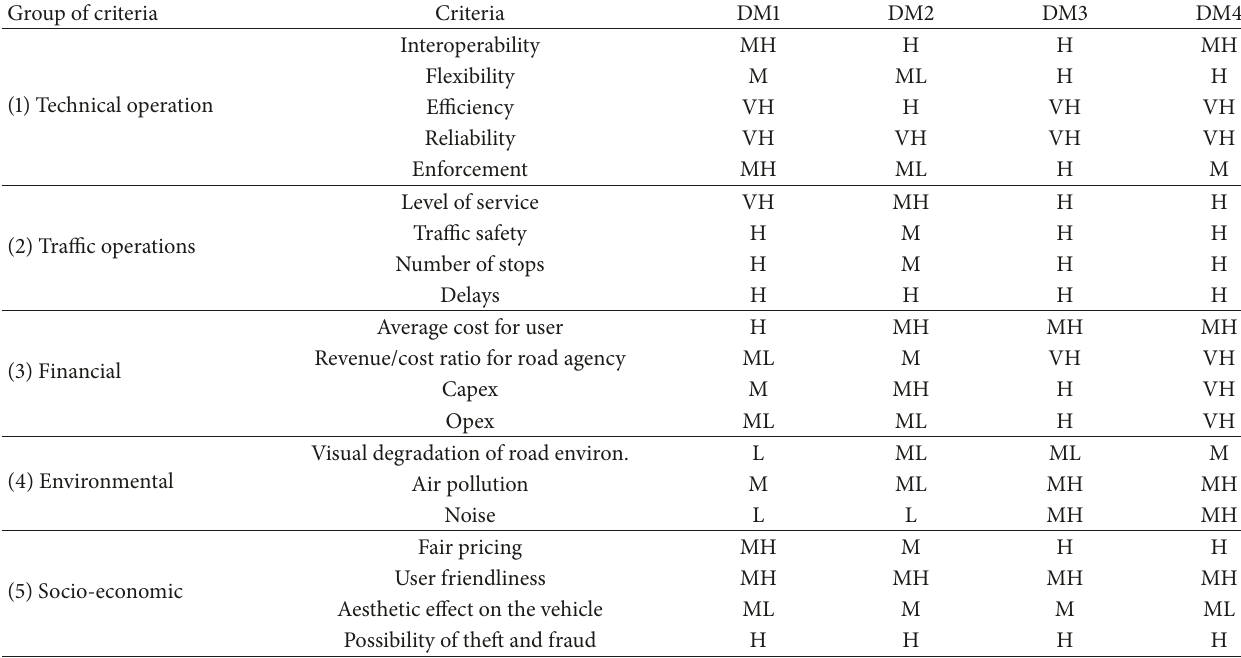
Table 5: The importance of criteria according to experts expressed by linguistic terms.